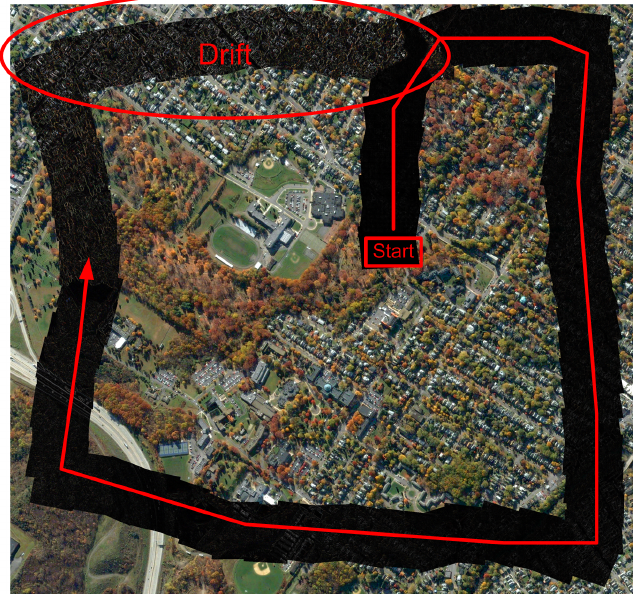
Figure 6. Difference between a reference ortho-photo and a mosaic strip showing the increasing drift in the final